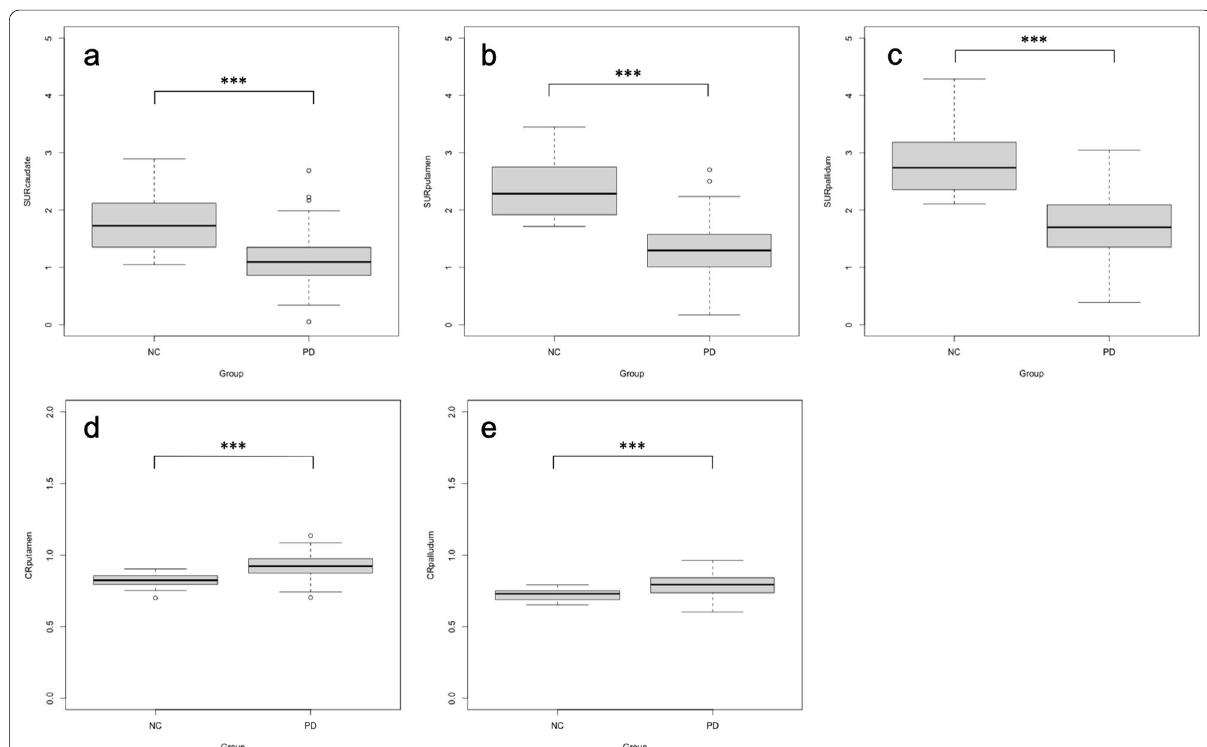
Fig. 3 Striatum uptake ratio (SUR) and caudate ratio (CR) between the normal control and Parkinson’s disease for test dataset 2. Box-and-whisker plots indicate the semi-quantitative indices distribution. a SUR caudate , b SUR putamen , c SUR pallidum ; d, CR putamen , e CR pallidum . *** P <